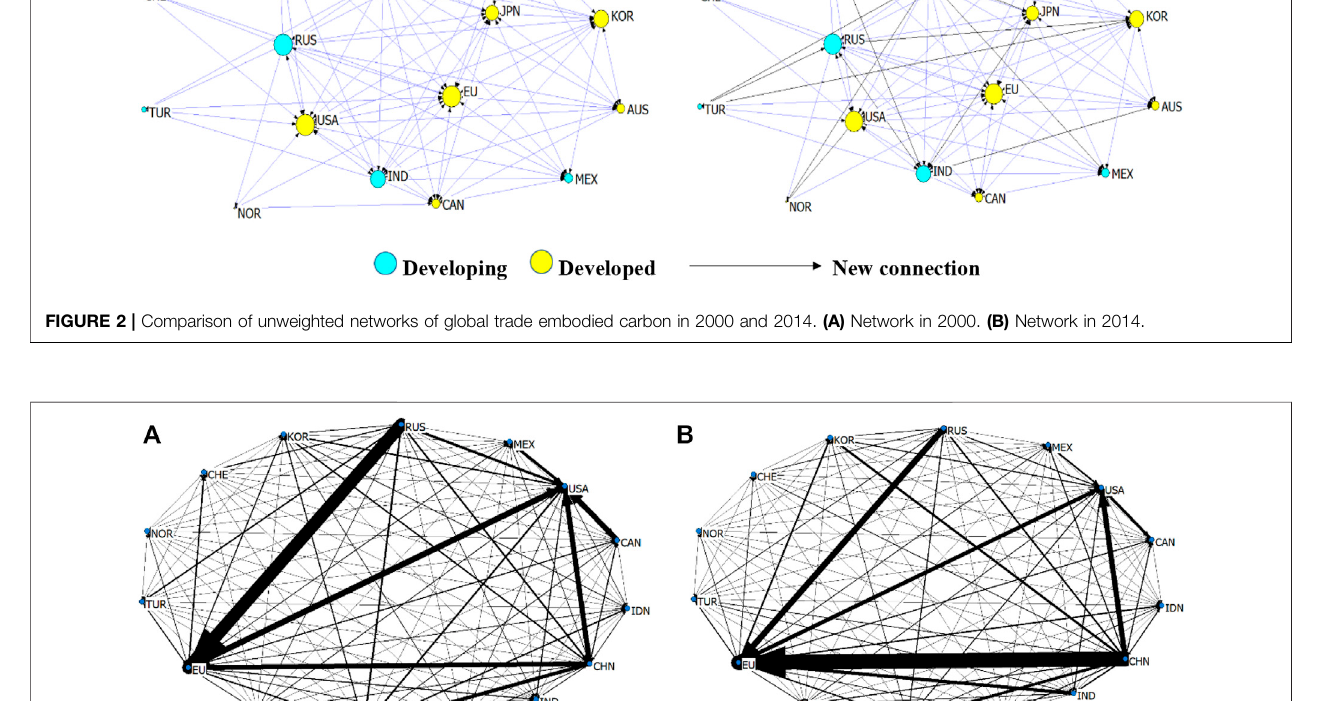
Figure 3 about the Weighted Networks of Embodied Carbon